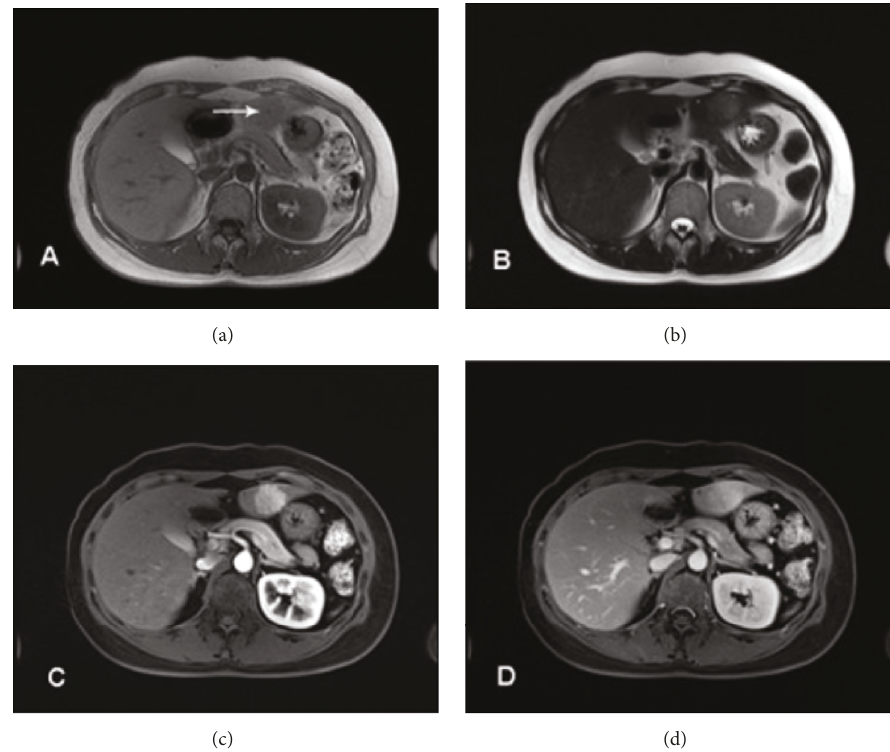
Figure 3: Abdominal magnetic resonance imaging (MRI) findings: (a) T1-weighted image shows that the lesion is slightly hypointense with the central scar appears more significant hypointense (arrow); (b) T2-weighted images shows the same lesion as slightly hyperintense; (c) after enhancement, the signal of the lesion is markedly increased and appears hyperintense during the arterial phase except for the central area in fat-saturated T1-weighted image; (d) in the portal venous phase, the lesion is slightly hyperintense compared to the normal liver tissue and the central scar is poorly